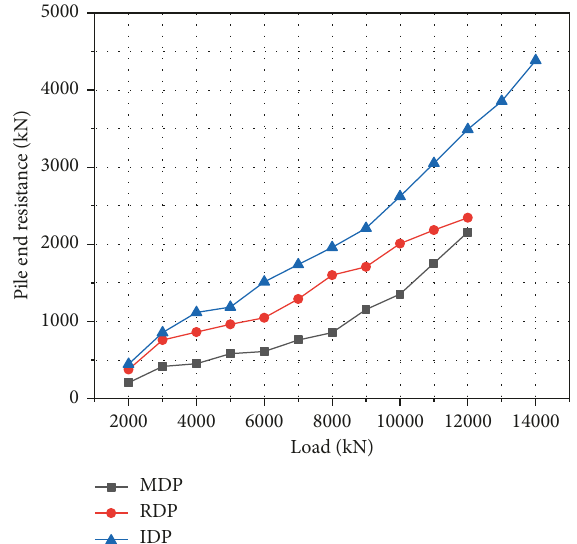
Figure 16: Pile end resistance of test piles under different